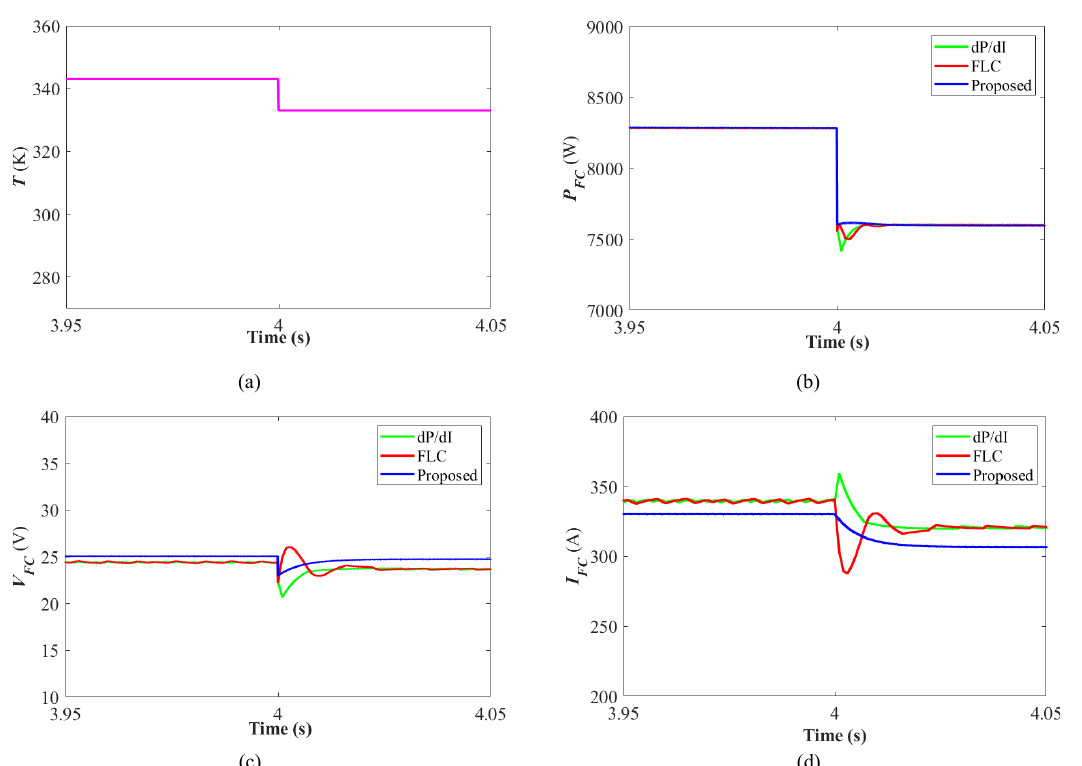
Figure 15. Results and comparisons at scenario 3: ( a ) T ; ( b ) P FC ; ( c ) V FC ; ( d ) I FC